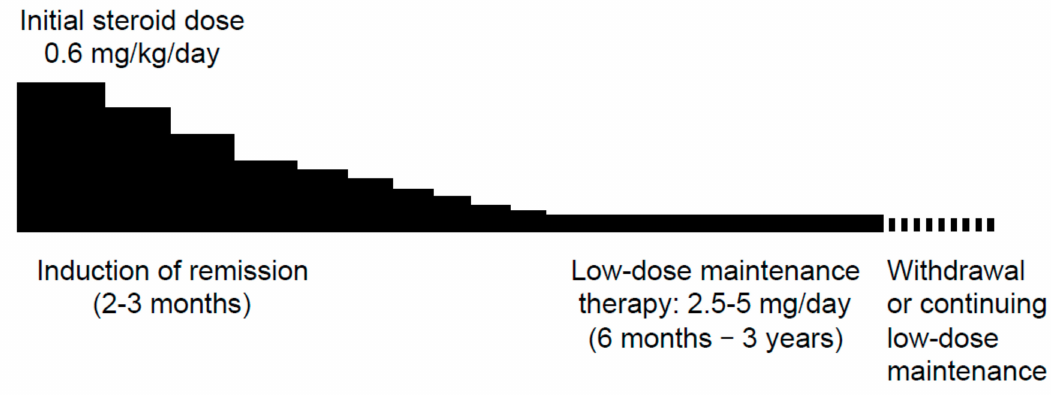
Figure 1. A timetable of standard oral corticosteroid